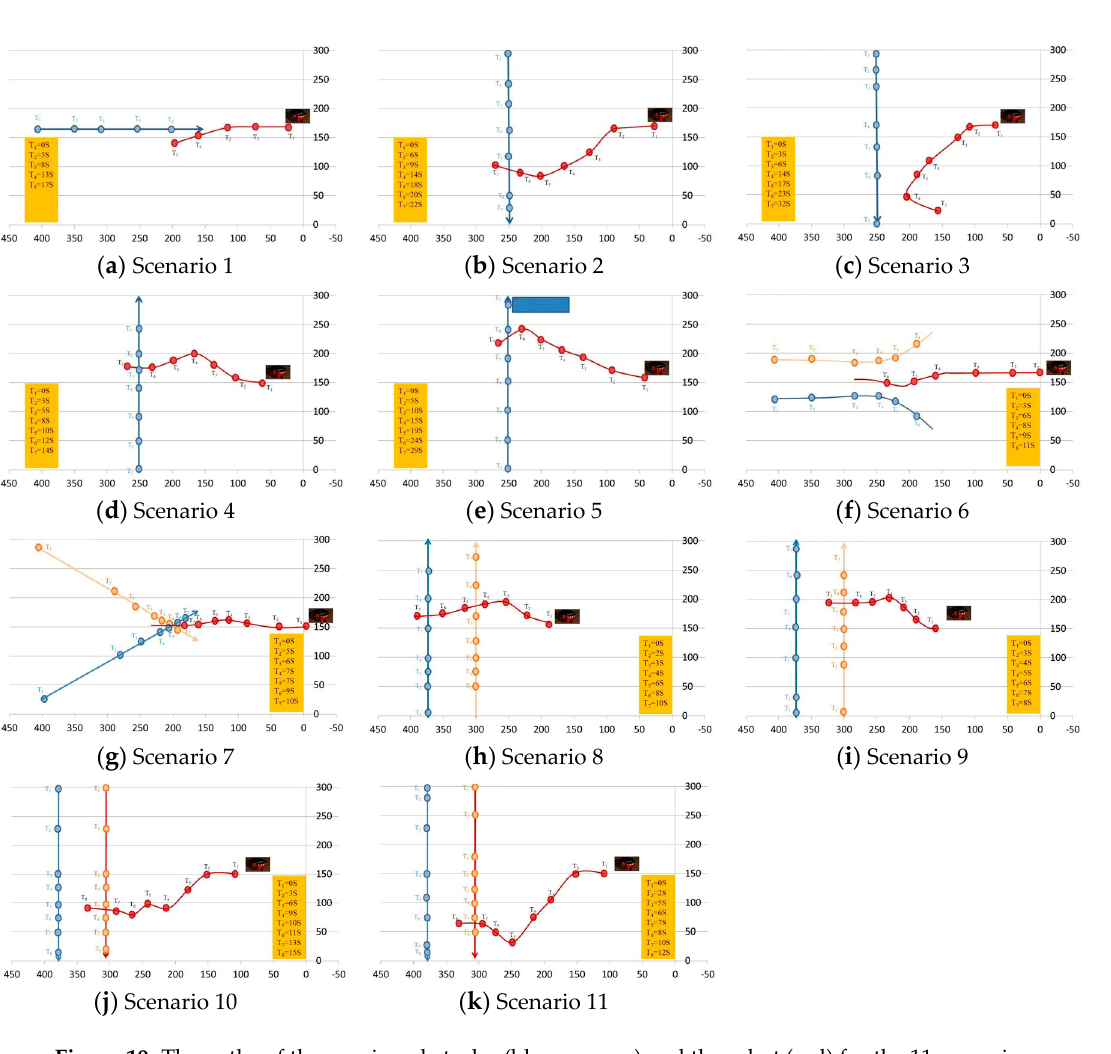
Figure 19. The paths of the moving obstacles (blue, orange) and the robot (red) for the 11 scenarios.